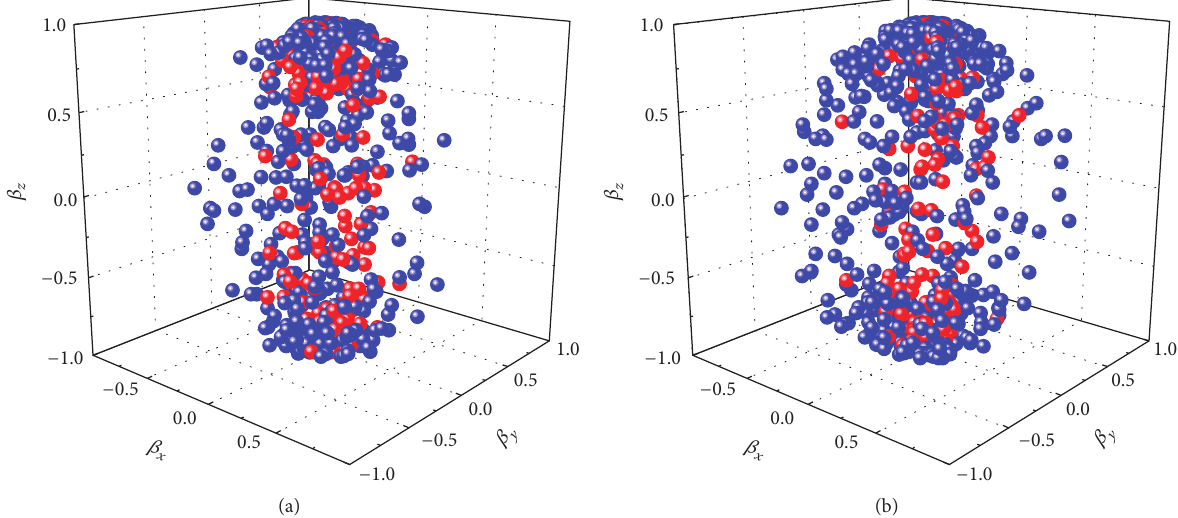
Figure 13: Same as Figure 4, but showing the results for (a) Υ(1𝑆) and (b) Υ(2𝑆) mesons produced in Pb-Pb collisions at √𝑠 NN = 2.76 TeV.